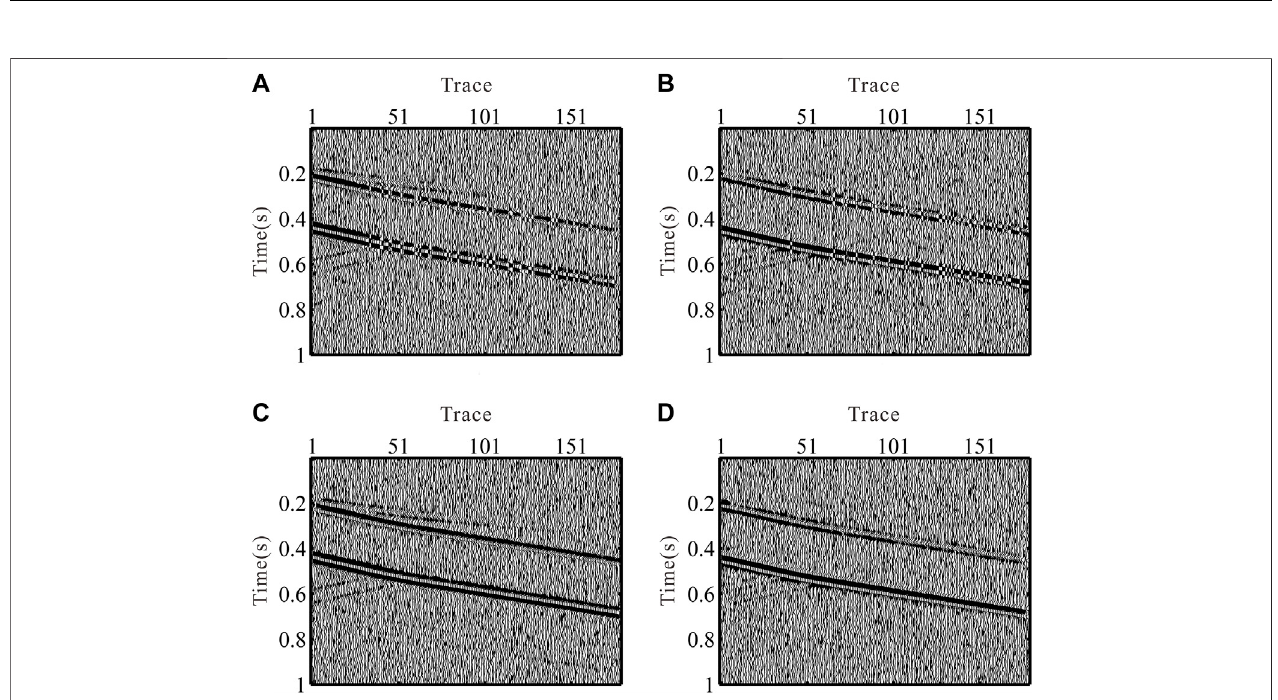
FIGURE 5 | (A) R- and (B) T-component VSP data generated by the largest eigenvector of covariance matrix (C). R- and (D) T-component generated by the proposed method.